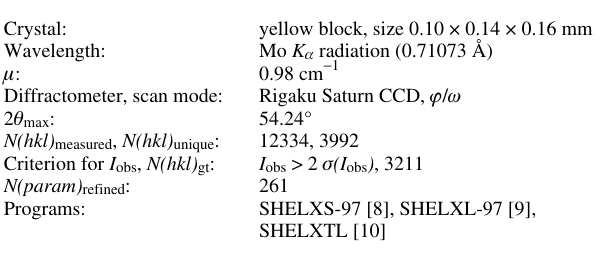
Table 1. Data collection and handling.